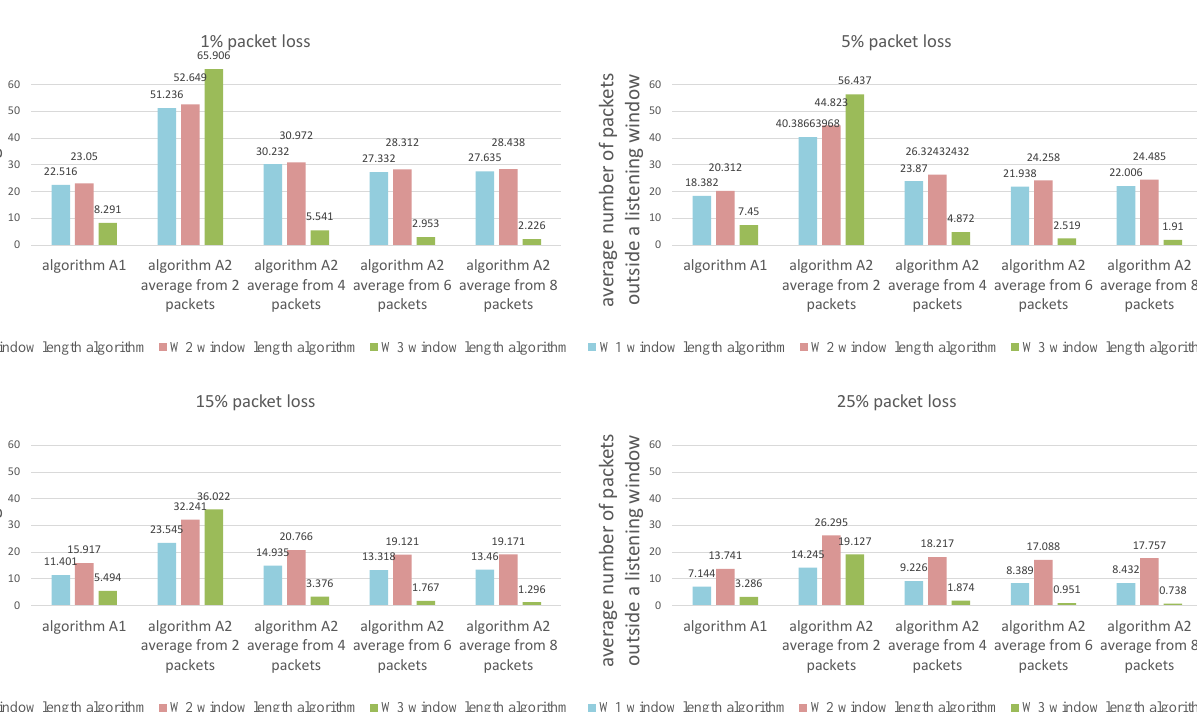
Figure 9. Comparison of algorithms in terms of the average number of packets outside the listening